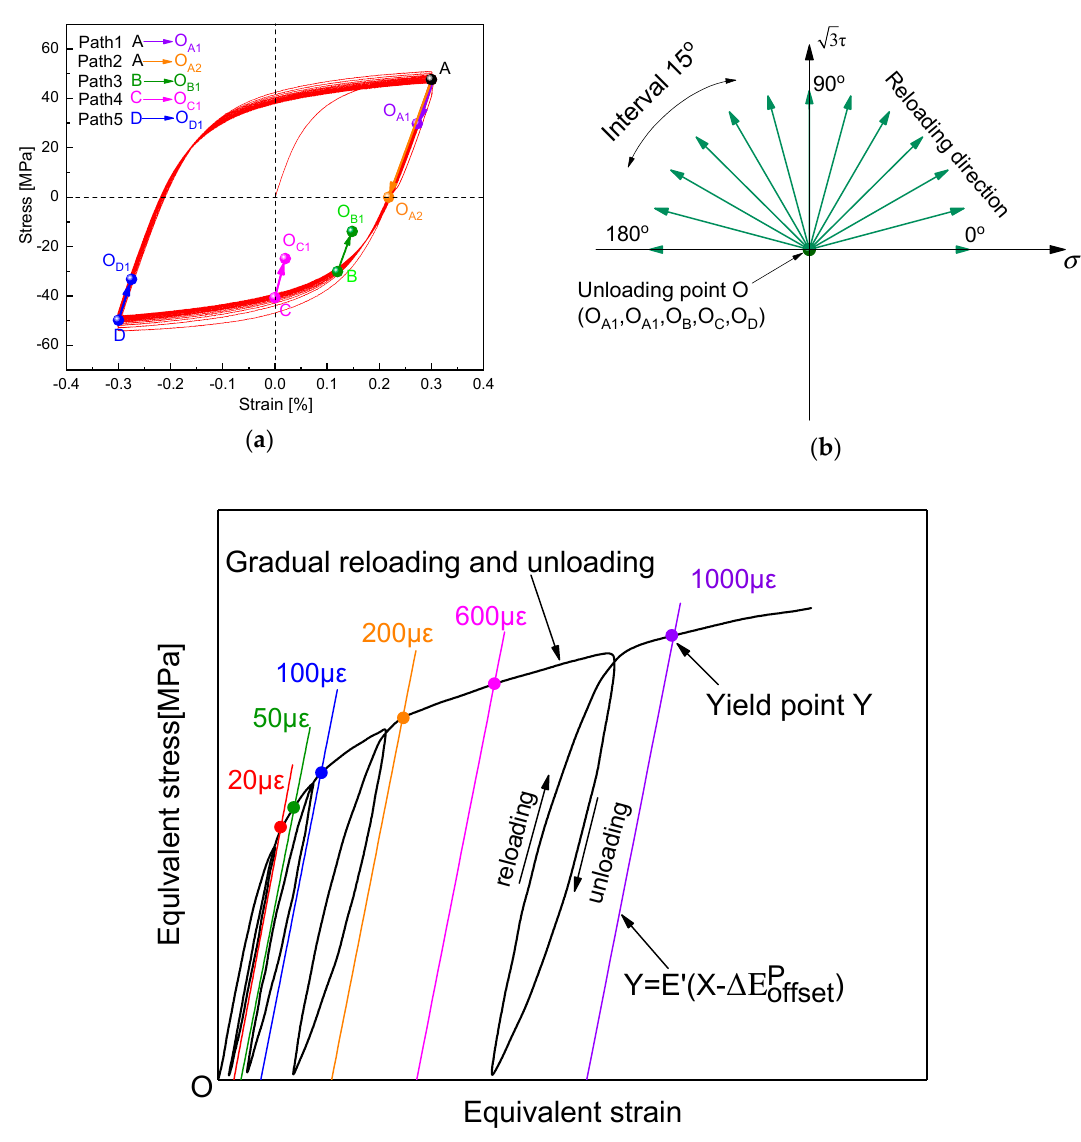
Figure 4. Preloading, unloading and reloading paths for probing the subsequent yield surface by experiments and numerical simulations: ( a ) different unloading end positions after pre-cyclic tension-compression loading, ( b ) reloading direction under combined tension-torsion proportional load, ( c ) Schematic diagram of yield point definition for yield surface.